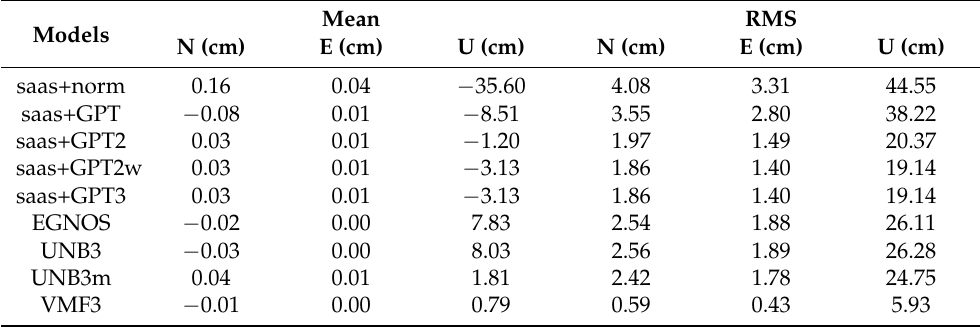
Table 5. Means and RMSs of the Single Point Positioning (SPP) solutions generated by the dZTD obtained by the 9 methods (saas+norm/GPT/GPT2/GPT2w/GPT3, EGNOS, UNB3, UNB3m, VMF3) on North (N), East (E), and Up (U) direction (unit: cm). Mean Models